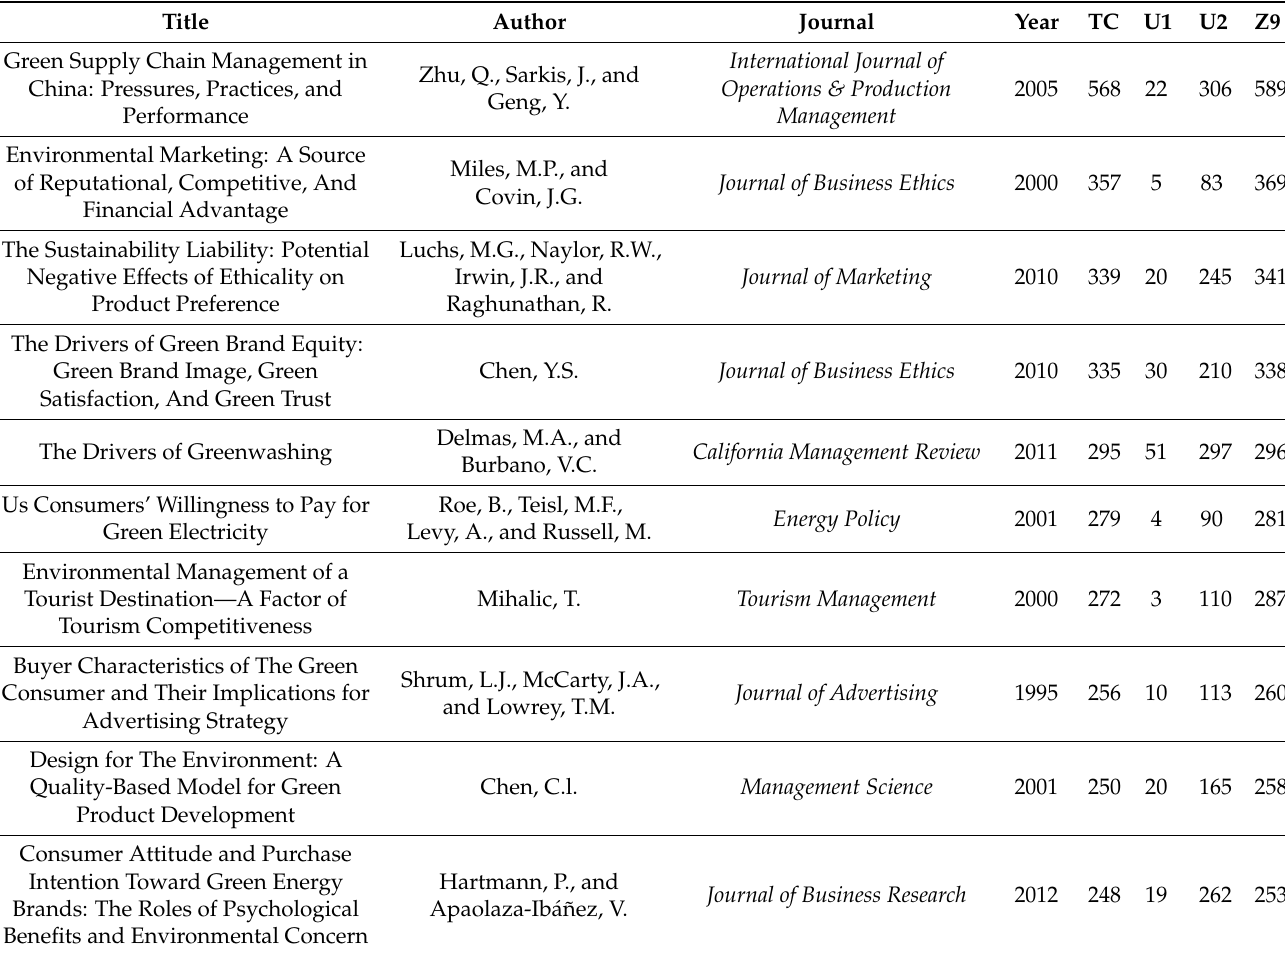
Table 5. Top ten most cited articles on green